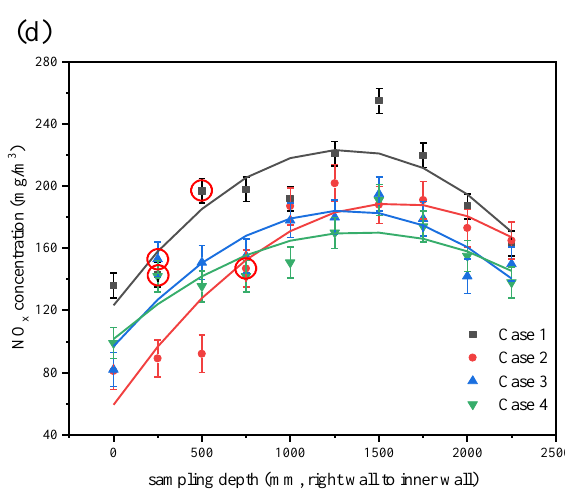
Figure 5. Distributions of flue gas composition along the horizontal direction of the upper measurement port under various working conditions (( a ) O 2 ; ( b ) CO; ( c ) SO 2 ; ( d ) NO x ; red circled points represent the position that fuel particles are bound to reach).